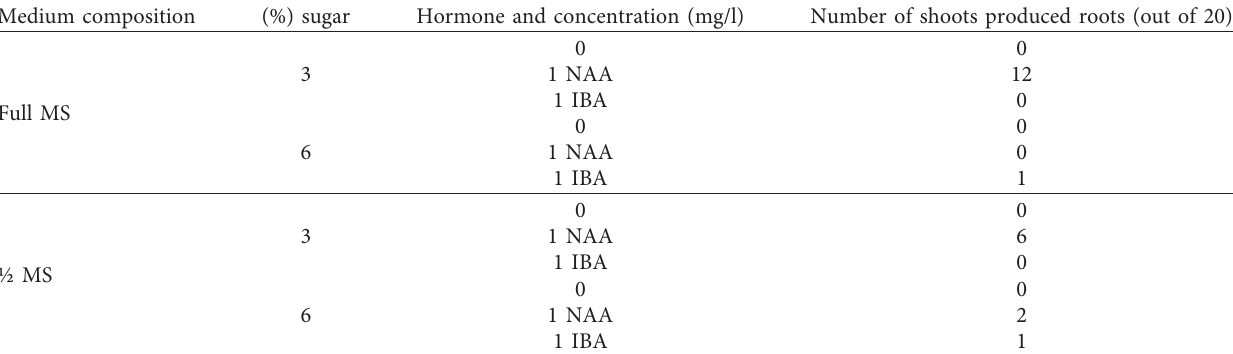
Figure 4: The nonvitrified shoots generated by lower BAP concentrations. The shoots are prepared for measurements and subculturing. Scale bar represents one cm. Table 3: Effect of N, hormone, and sugar levels on rooting of in vitro cultures of